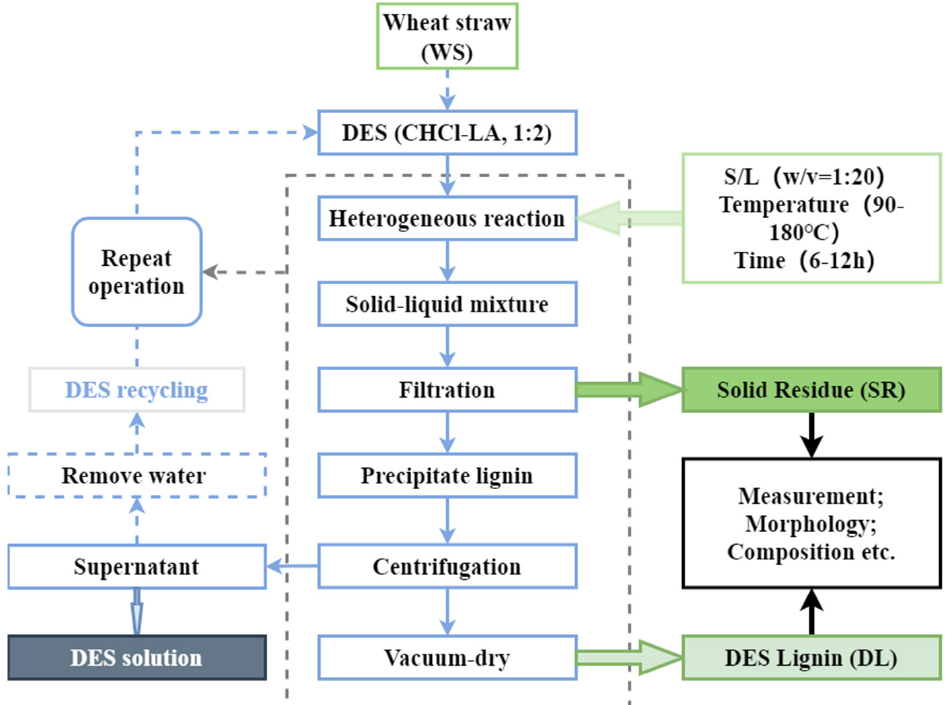
Figure 1. Flow chart for lignin extracted by DES.